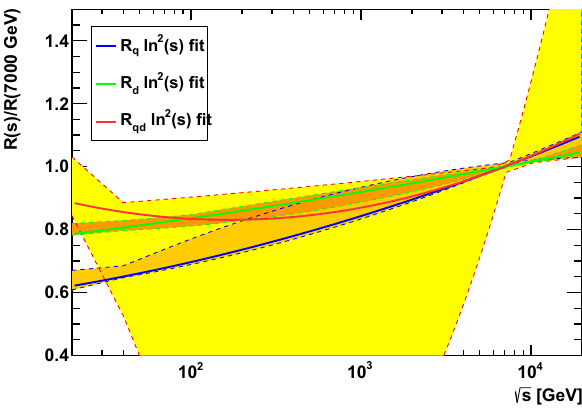
Fig. 22 Systematic error band on the R d ( s ) parameter as obtained by systematicallyshiftingandfixingthebest R d valuesupanddownbyone standarddeviationateachenergywheretheyaredetermined( 2 . 76, 1 . 96, 0 . 546 TeV and 23 . 5 GeV) and then re-fitting all the other parameters to account for the correlations between the parameters of the ReBB model. The central line indicates the best estimate for the quadratic in ln ( s ) polynomial for R d ( s )